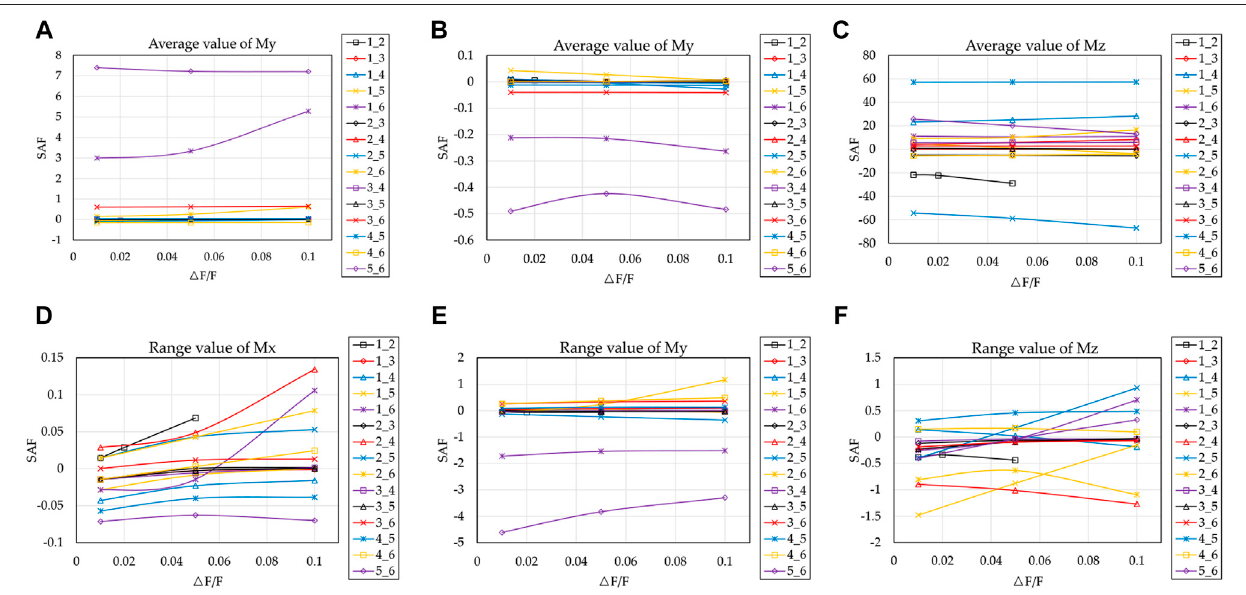
FIGURE 6 | Sensitivity of non-main diagonal stiffness to blade root moment.